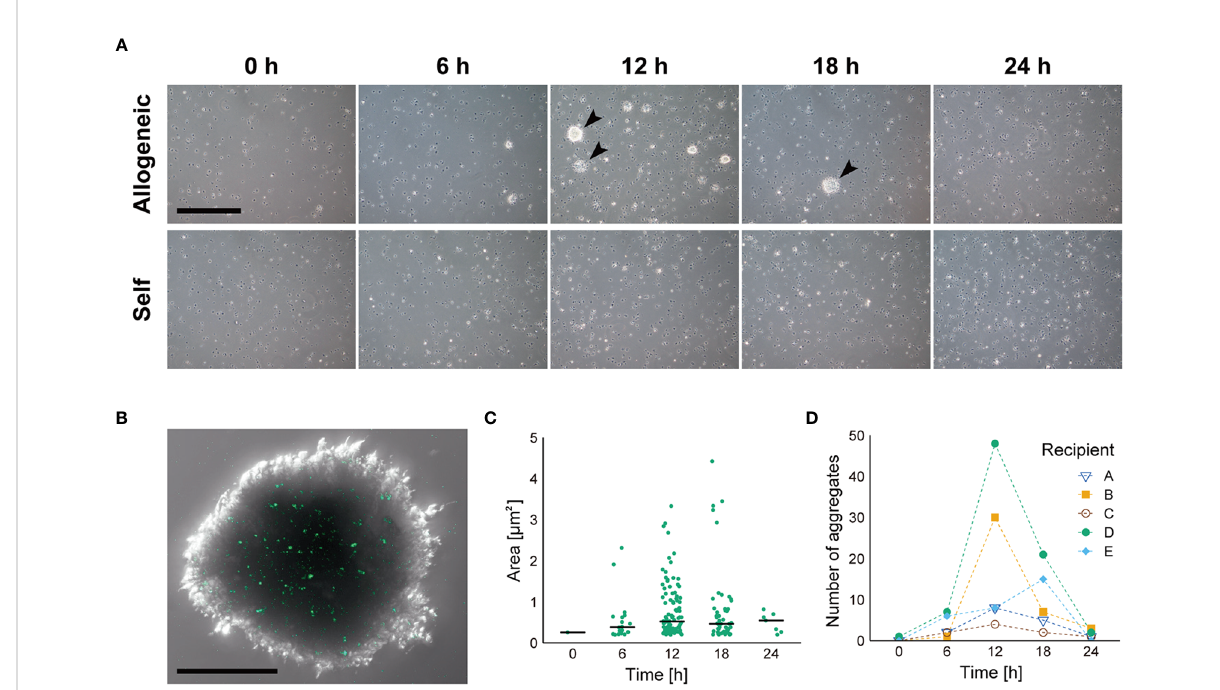
FIGURE 2 Dynamics of coelomocyte aggregate formation in response to injected allogeneic coelomocytes. (A) Time course of allorecognition response to allogeneic coelomocytes. Arrow heads indicate coelomocyte aggregates. Scale bar: 500 µm. (B) Magni fi ed image of coelomocyte aggregate in response to fl uorescently labeled allogeneic coelomocytes. Scale bar: 100 µm. (C) Temporal change in the size of coelomocyte aggregates, shown in (A) , after injection of allogeneic coelomocytes. Horizontal bars indicate the median size at each time interval. (D) Temporal change in the number of coelomocyte aggregates after injection of allogeneic coelomocytes in each